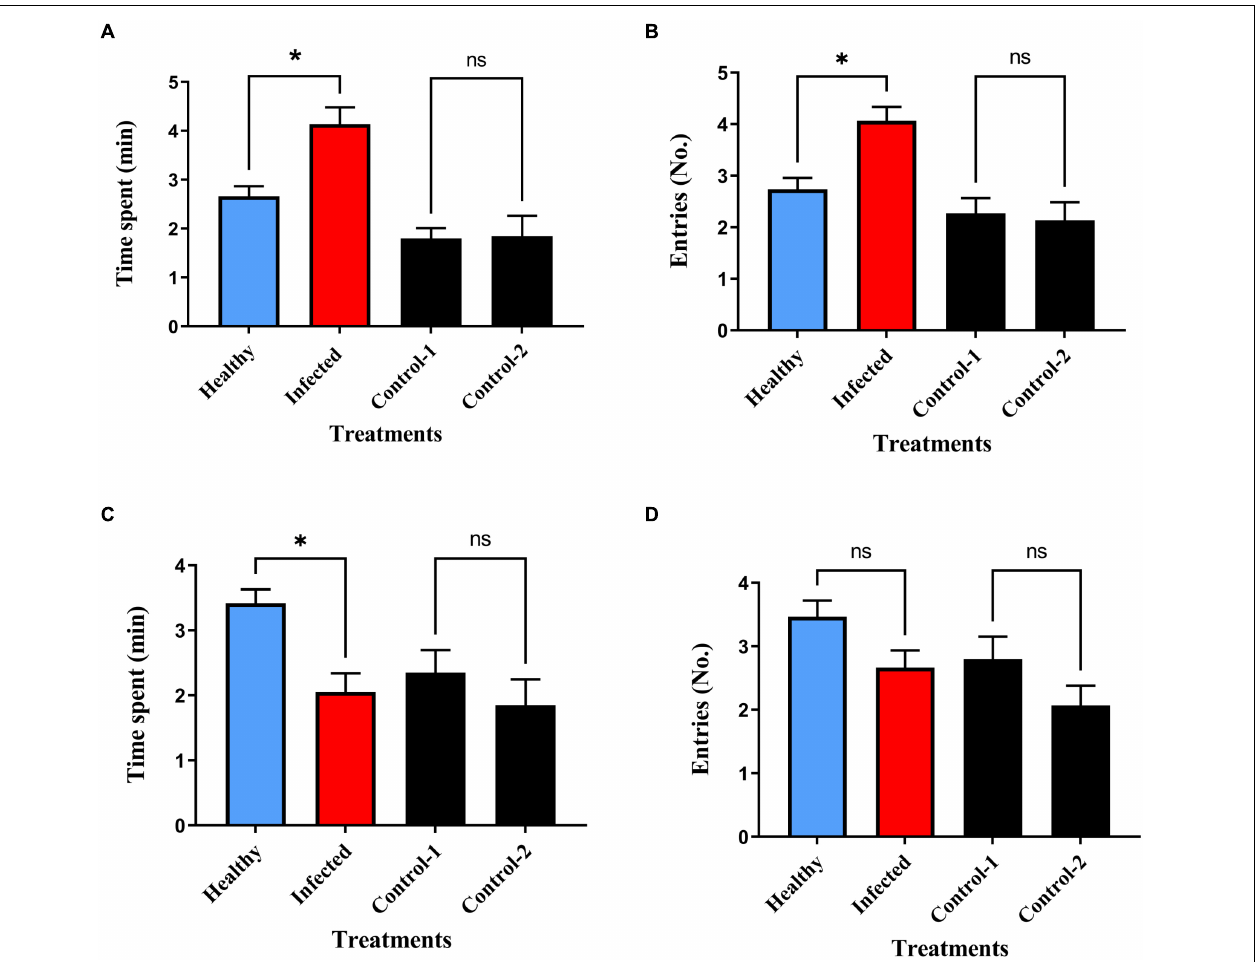
FIGURE 1 | Behavioral response of B. tabaci to chili plant volatiles in olfactometer bioassays (A,B) non-viruliferous females to healthy (blue bars) and ChLCV infected plant (red bars) volatiles, ∗ in (A,B) indicates P = 0.05, 0.03, respectively. (C,D) Viruliferous females to healthy and ChLCV infected plant volatiles, ∗ in (C) indicates P = 0.02. *denotes P ≤ 0.05; ns =